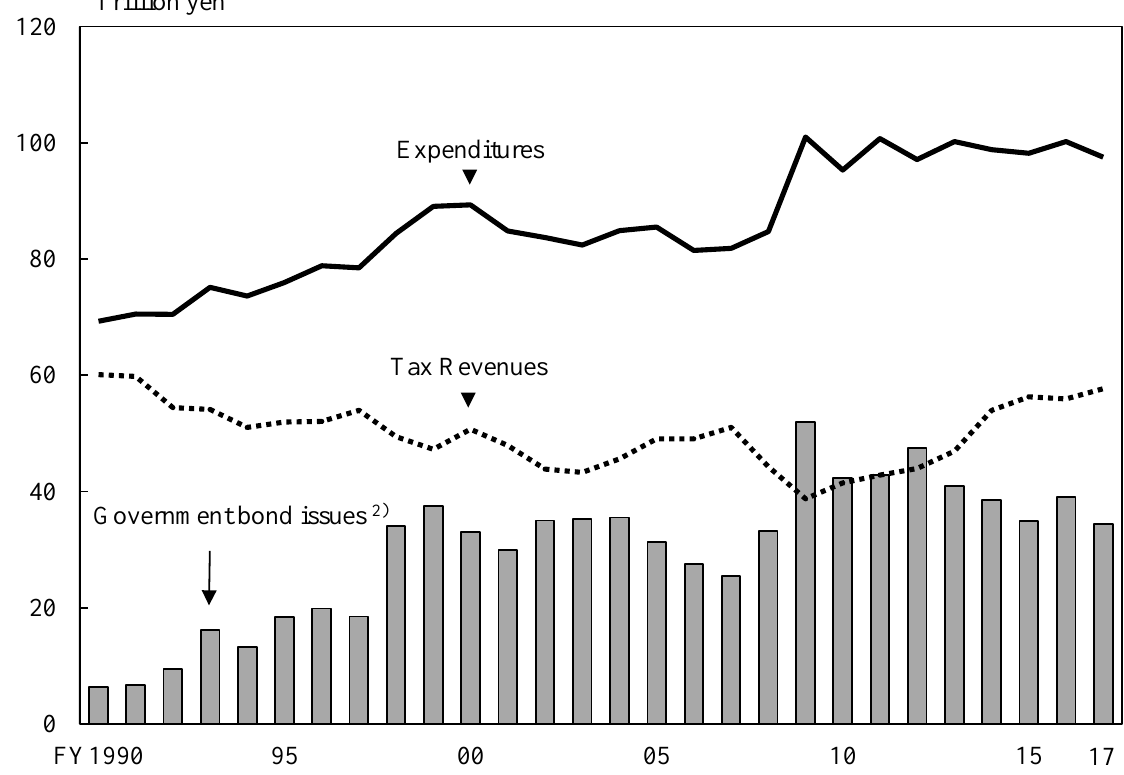
Figure 4.1 Revenues and Expenditures in the General Account